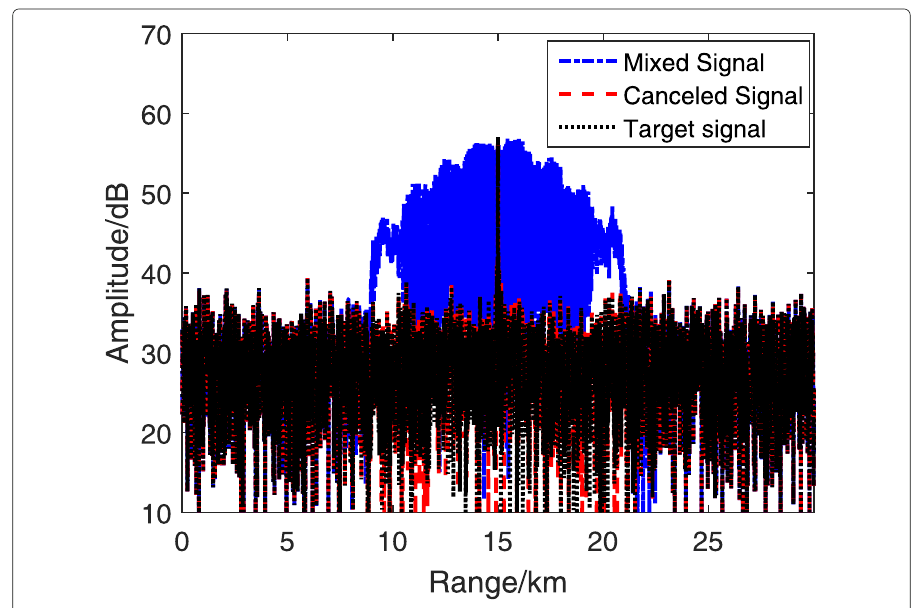
Fig. 4 The pulse compression results of different signals